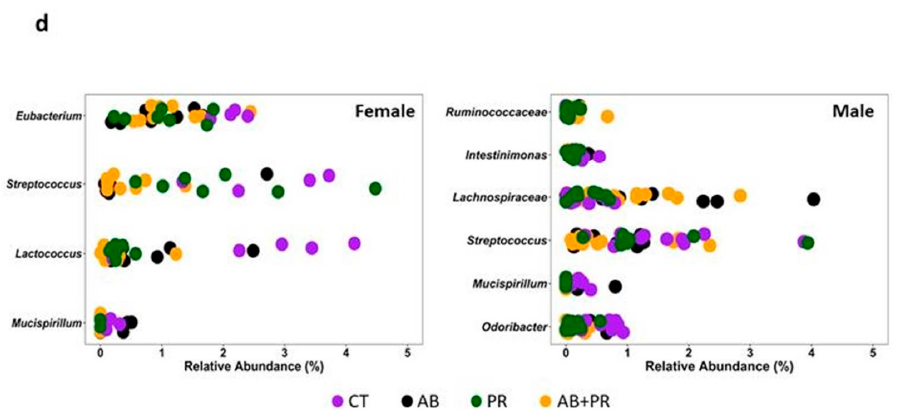
Figure 6. ( a ) Evenness and richness of cecal microbiota across different treatments; ( b ) PCoA plots of cecal microbiota calculated from UniFrac distance (weighted) matrix; ( c ) weighted UniFrac distance matrix-based analysis in females and males; ( d ) relative abundance across treatment groups in females and males. Values are mean ± SEM ( n = 10–11 / group). CT: control; AB: antibiotic; PR: prebiotic; AB + PR: antibiotic plus prebiotic.